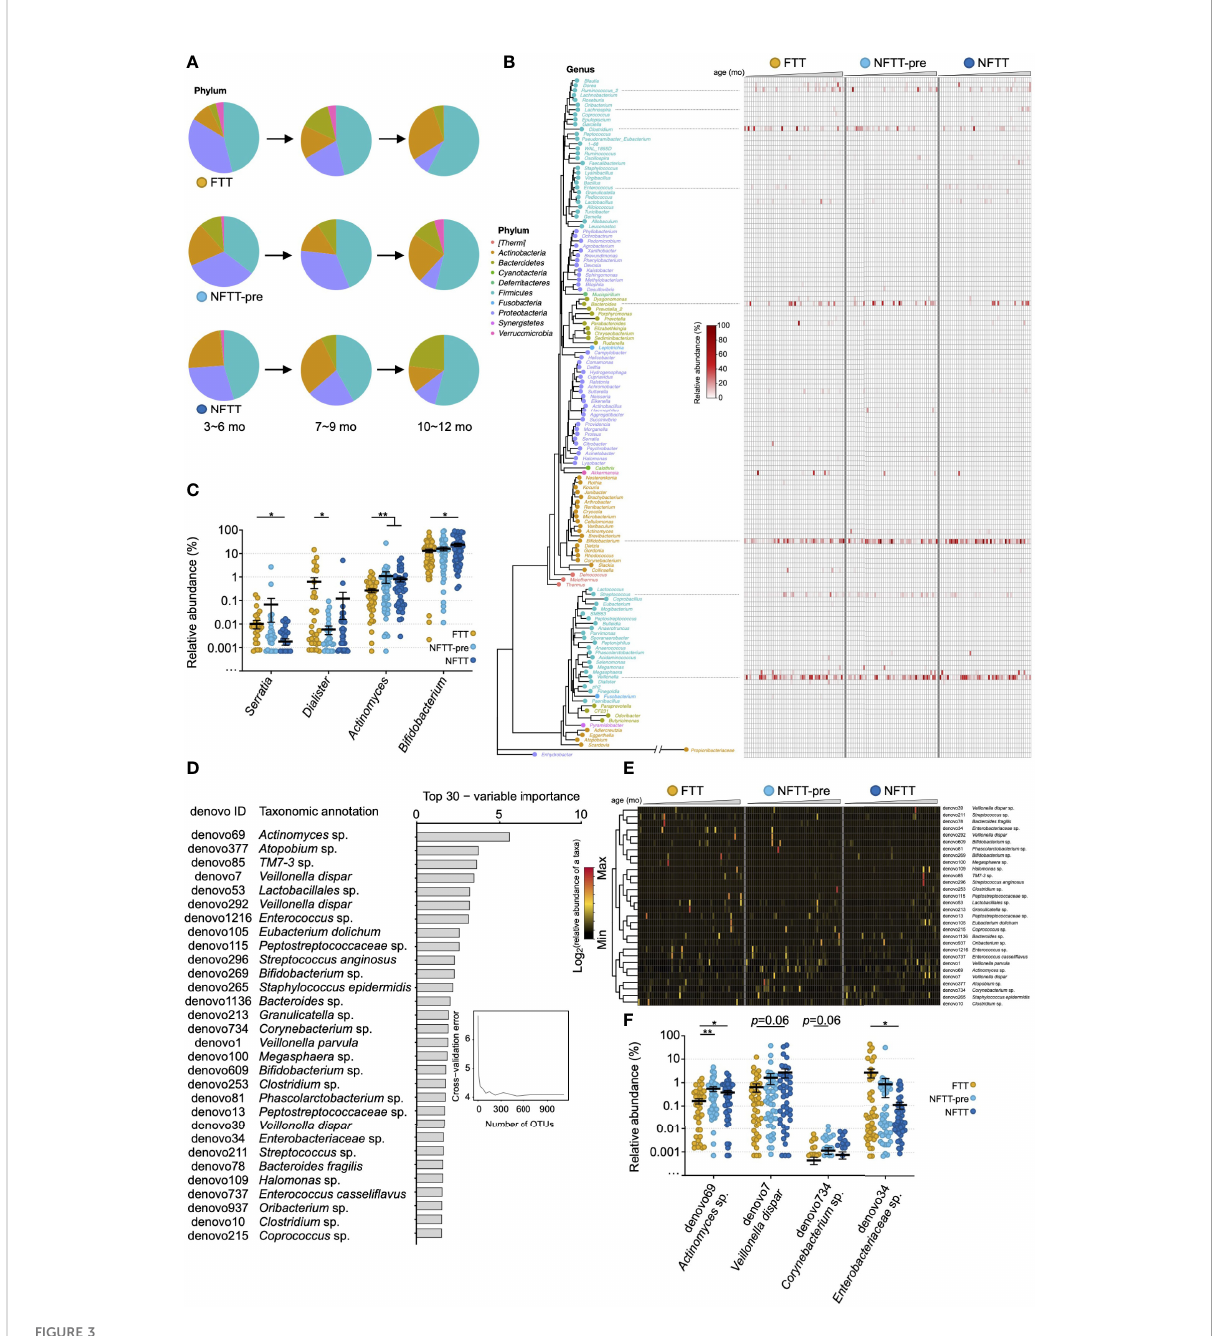
FIGURE 3 Colonization of gut microbiota in FTT and NFTT-pre groups differ from those of the NFTT group across age at different phylogenetic level. (A) Pie charts indicate the gut microbiota composition (mean relative abundance) at the phylum level across infant chronological age. (B) Neighbor joining phylogenetic tree of all of the 140 annotatable genera. Text indicates the generic name of each bacterial taxa (plot), and the color of the text and plot represents the level of phylum of each genus. Heatmap indicates the relative abundance of the speci fi c genus in different groups. Samples are arranged from younger (left) to older (right). (C) Relative abundance of the 4 signi fi cant altered genera, including Serratia , Dialister , Actinomyces and Bi fi dobacterium , among the FTT, NFTT-pre and NFTT groups. Mean values ± SEM are plotted. Kruskal-Wallis test, * p < 0.05 and ** p < 0.01. (D) A total of 30 age-discriminatory OTUs with the most variable importance identi fi ed via random forest regression of relative abundances of fecal bacterial taxa at the OTU level against infant chronologic age in NFTT subjects. The age- discriminatory OTU values are ranked in descending order of their importance to the accuracy of the model. (E) Heatmap indicates the relative abundance of the 30 most age-discriminatory bacterial taxa (OTU level) in the different groups. Samples are arranged from younger (left) to older (right). (F) Relative abundance of the 4 signi fi cant altered OTUs, including Actinomyces sp. (denovo69), Veillonella dispar (denovo7), Corynebacterium sp. (denovo734) and Enterobacteriaceae sp. (denovo34), among the FTT, NFTT-pre and NFTT groups. Mean values ± SEM are plotted. Kruskal-Wallis test, * p < 0.05 and ** p <